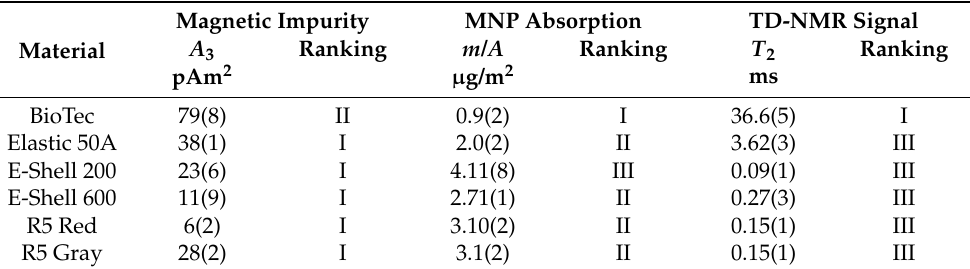
Table 1. Summary of the material selection procedure. A ranking is presented for each investi- gated property (I: best suitable, II: questionable suitability, III: unsuitable). The number in the pa- renthesis indicates the uncertainty in the last digit.